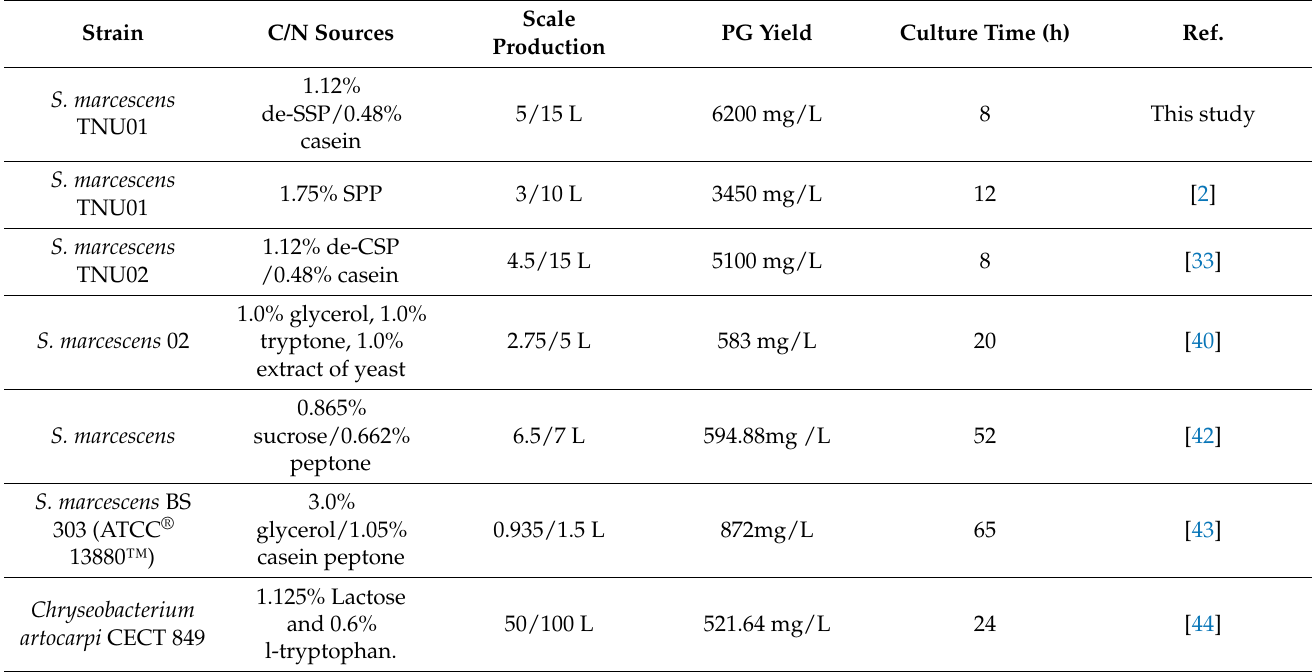
Table 3. Scale-up of PG production in bioreactors from different studies.